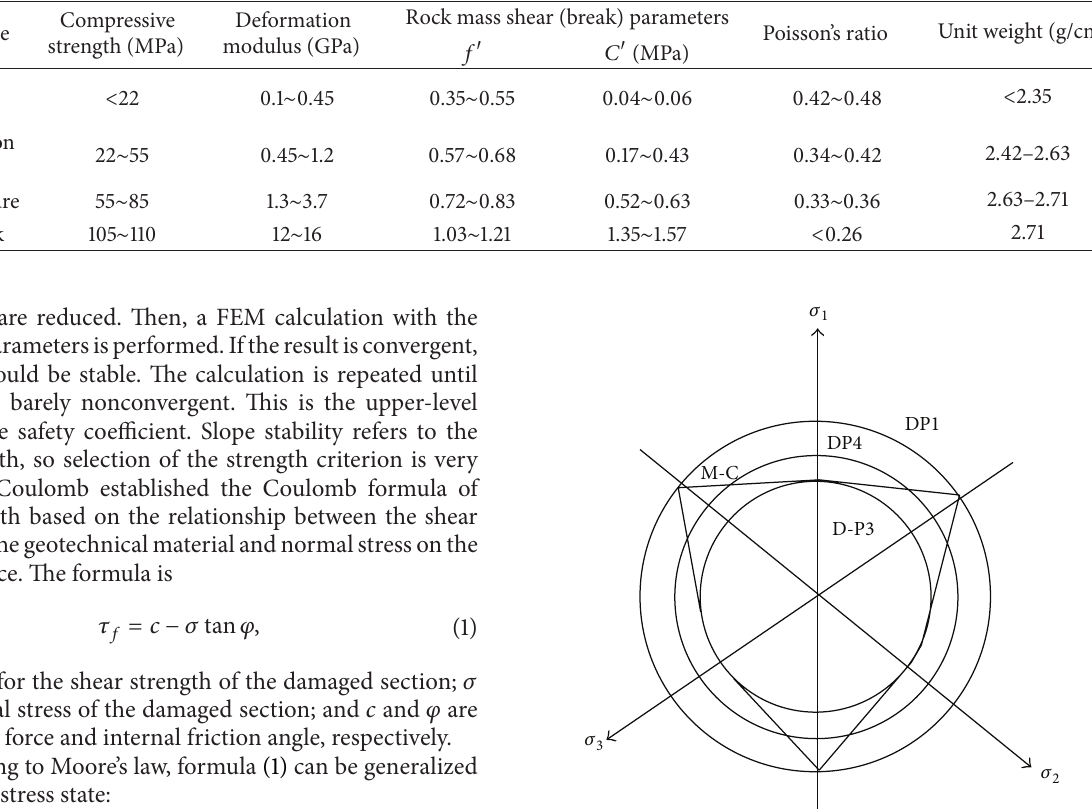
Table 3: Rock mechanic parameters of different rock structures.